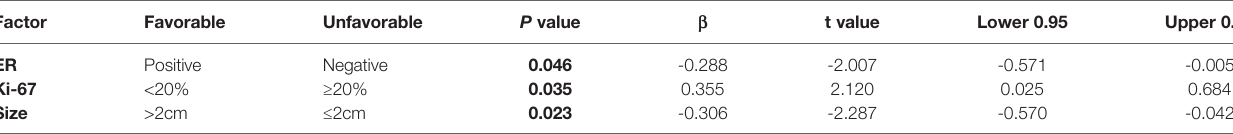
TABLE 3 | Multiple regression analysis showing the effect of different characteristics on